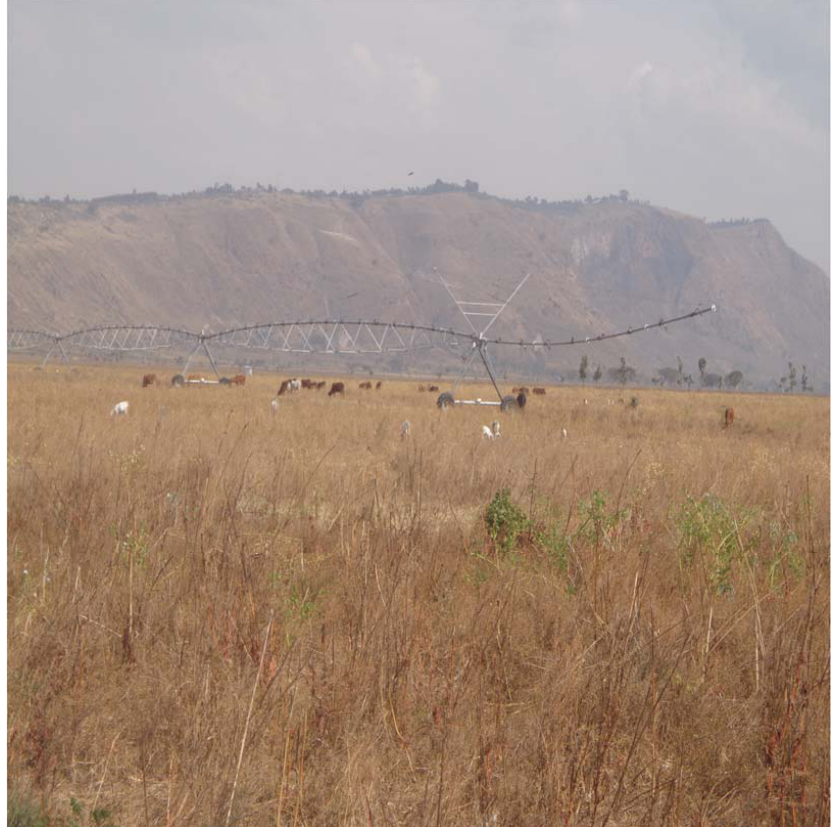
Figure 2. Elfora large ‐ scale crop production farm in the Shashamane district, which is responsible for planting, transplanting, growing, and harvesting plant material, including food crops and export/industrial crops (right side). (Source: authors).